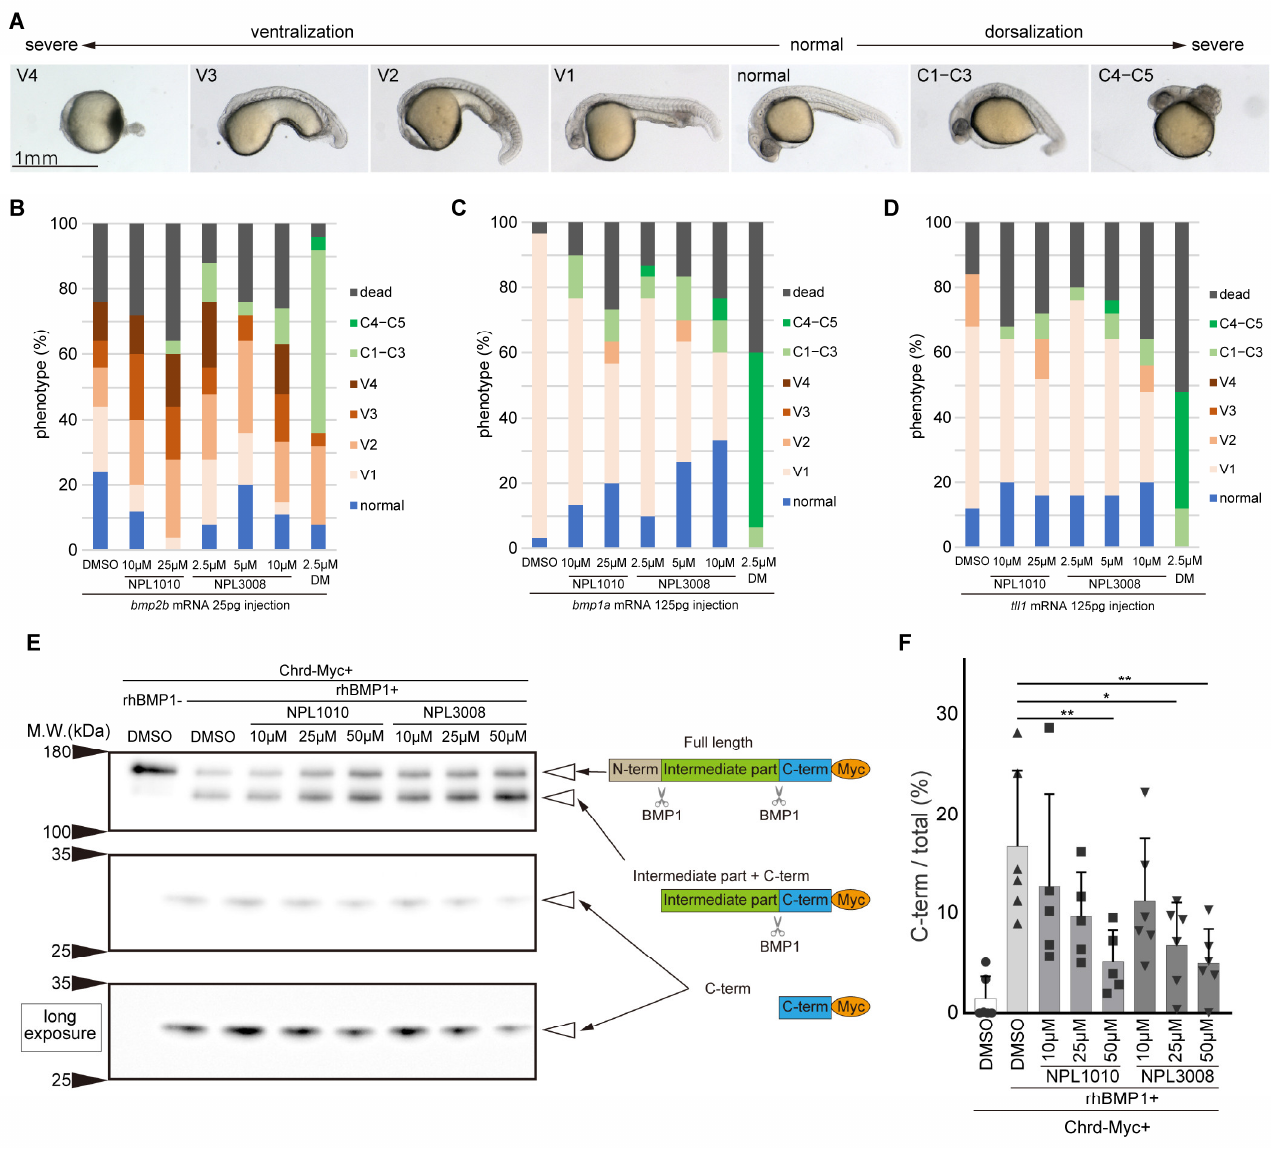
Figure 5. NPL1010 and NPL3008 inhibit BMP1-dependent Chrd cleavage. ( A ) Classification of ventralization and dorsalization phenotypes with representative phenotypes shown in the photographs. The phenotypes were classified into ventralized (V1 − V4), normal, and dorsalized (C1 − C5). Lateral view, anterior to the left. Scale bar, 1 mm. ( B – D ), Proportion of bmp2b ( B ), bmp1a ( C ), or tll1 ( D ) mRNA-injected embryos displaying the phenotype. DM: dorsomorphin. NPL1010 and NPL3008 partially rescue the bmp1a - or tll1 -induced ventralization phenotype ( n = 25–30). ( E ) Chrd cleavage assay. Chrd-Myc was incubated with rhBMP1. The effects of NPL1010 and NPL 3008 on BMP1-dependent Chrd cleavage were analyzed using Western blotting. The schematic illustration shows the cleavage patterns of Chrd. ( F ) Statistical analysis of the amount of cleaved Chrd detected in the Chrd cleavage assay. NPL1010 and NPL3008 dose-dependently inhibited BMP1-dependent Chrd cleavage. *: p < 0.05 and **: p < 0.01 (Dunnett’s test). Error bars indicate +s.d. with individual data shown ( n = 5–6).